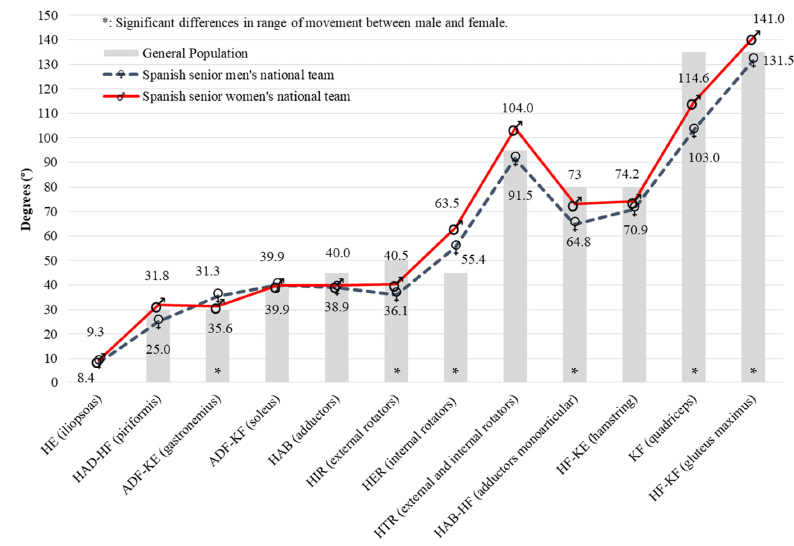
Figure 1. Flexibility profile differences between male and female elite inline hockey players, and general population. Average ROM values of both dominant and non-dominant extremities are